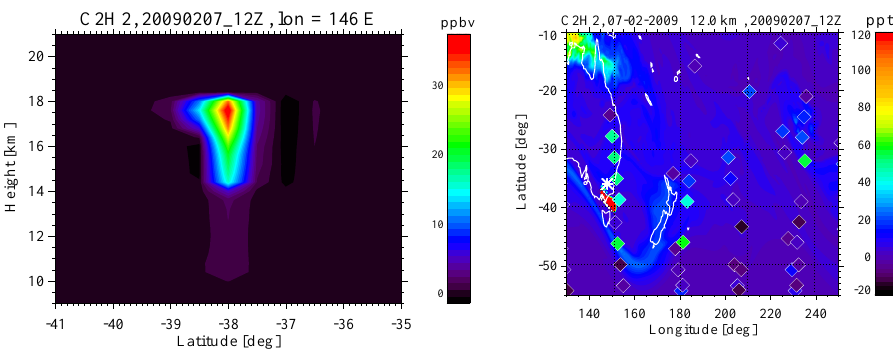
Fig. 9. Left: latitudinal cross section at 146 ◦ E through the GEM-AQ C 2 H 2 model plume from 7 February 2009, 12:00UT, in original resolution. Right: MIPAS C 2 H 2 data at 12km altitude (diamonds) from 7 February. The background area is the GEM-AQ C 2 H 2 model distribution of 12:00UT in original resolution. The white star indicates the location of the Kilmore East